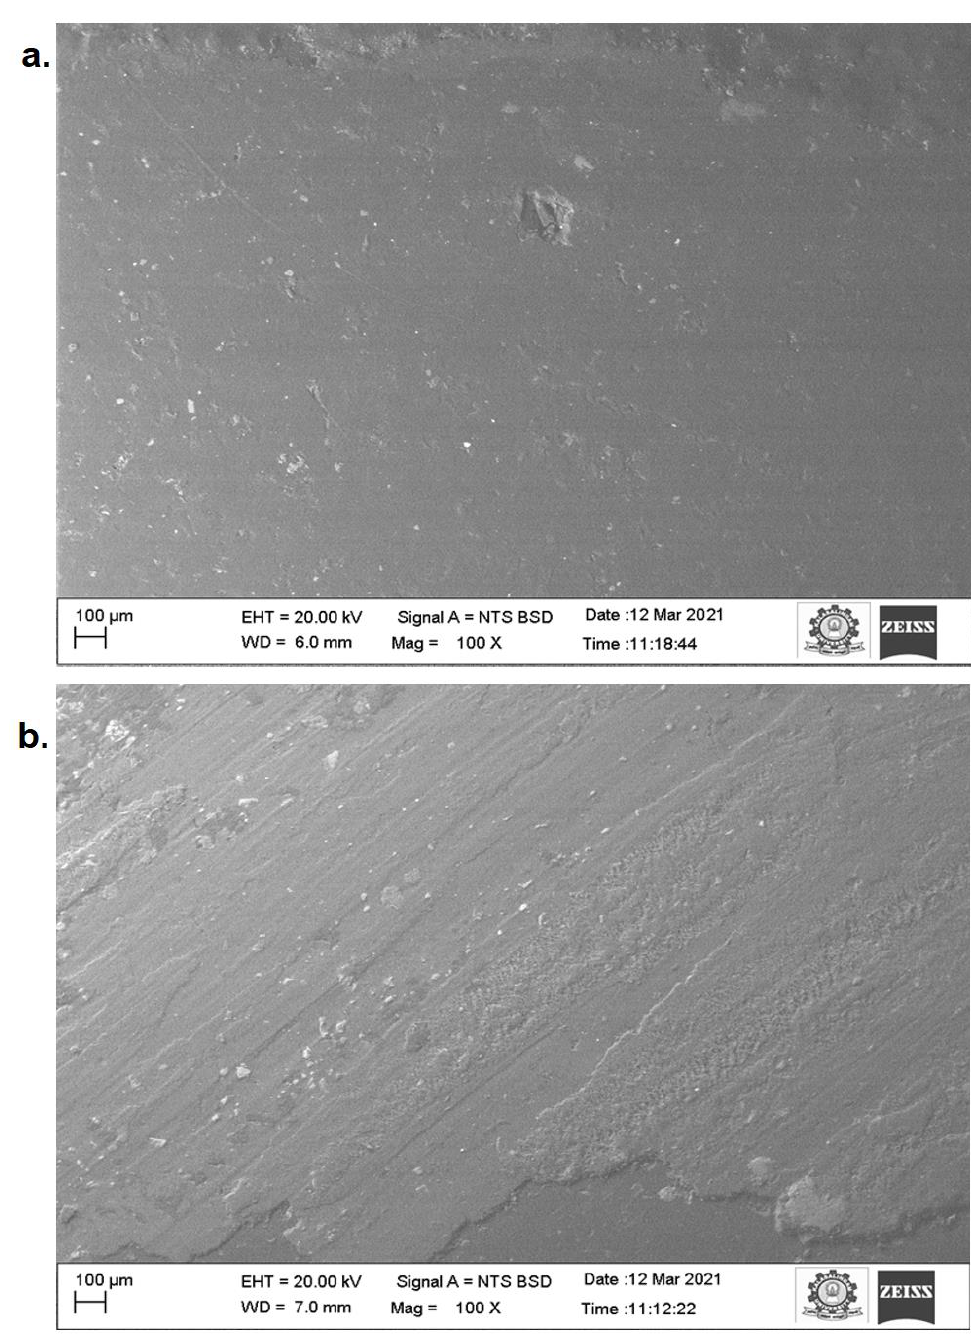
Figure 6. Sample with optimal conditions (sample n. 7): ( a ) Before wear test; ( b ) After wear test.